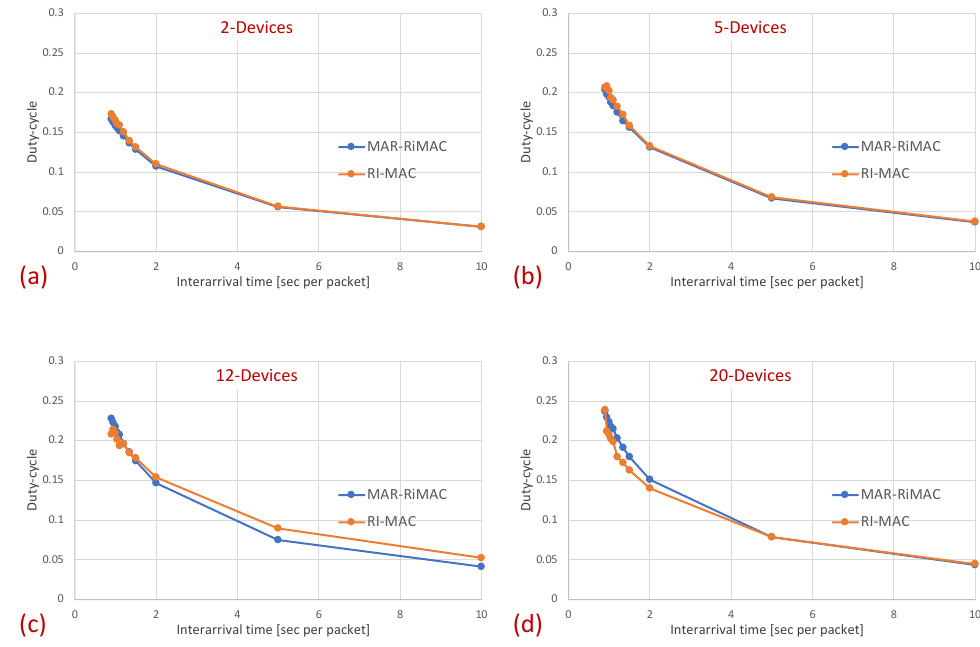
Figure 8. Clique topology: Mean duty cycle for different numbers of devices and K = 4. ( a ) Two devices. ( b ) Five devices. ( c ) Twelve devices. ( d ) Twenty